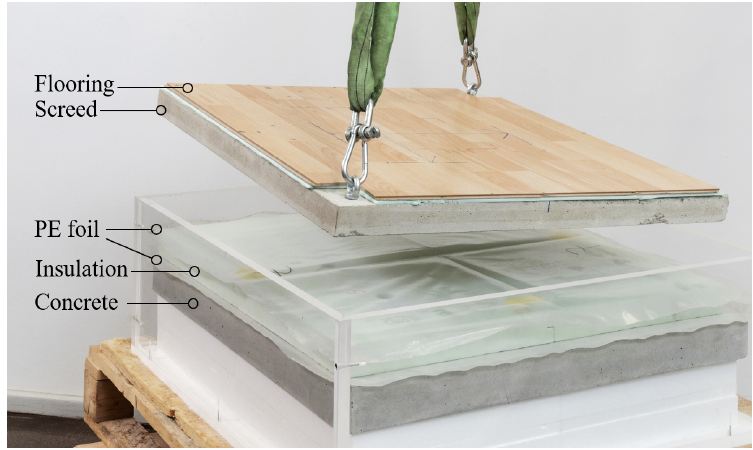
Figure 3. Modular test specimen with screed, insulation, and concrete base layer. Table 1. Used materials and layer thicknesses for the screed (top) and insulation layer